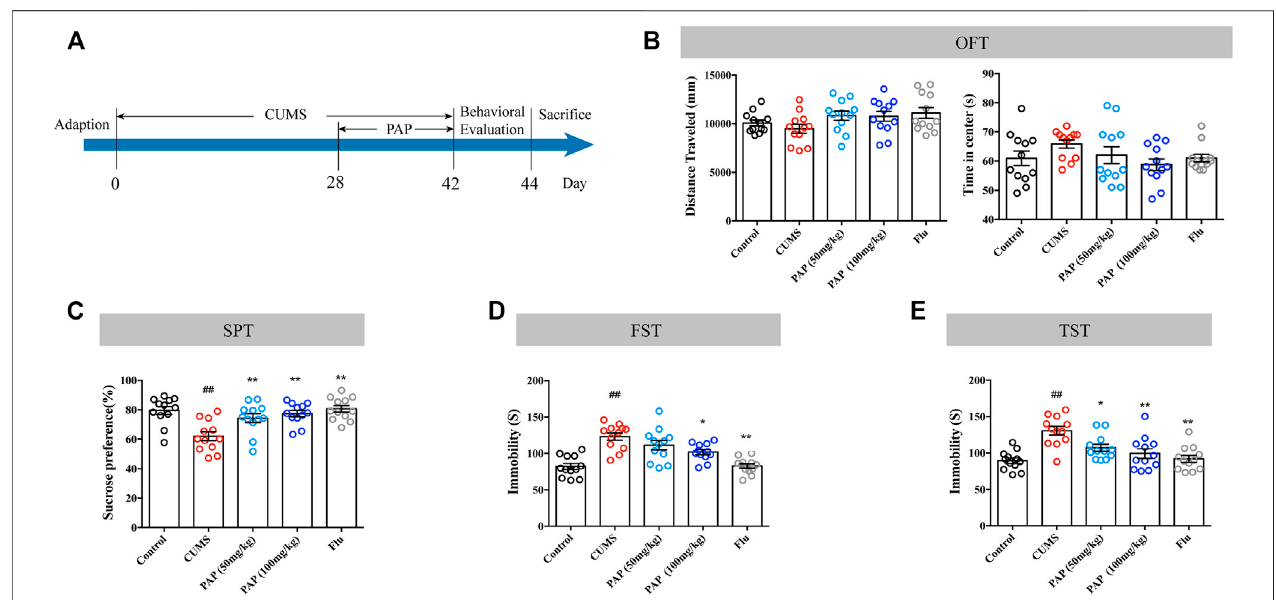
FIGURE1| EffectofPAPondepression-likebehaviors.ThescheduleofCUMSinductionanddrugtreatmentinexperiment1 (A) .Thedistancetraveledandtimein the center of the OFT (B) . The sucrose preference in the SPT (C) . The immobility in the FST (D) and TST (E) . ## p < 0.01 vs. control group, * p < 0.05, and ** p < 0.01 vs. CUMS